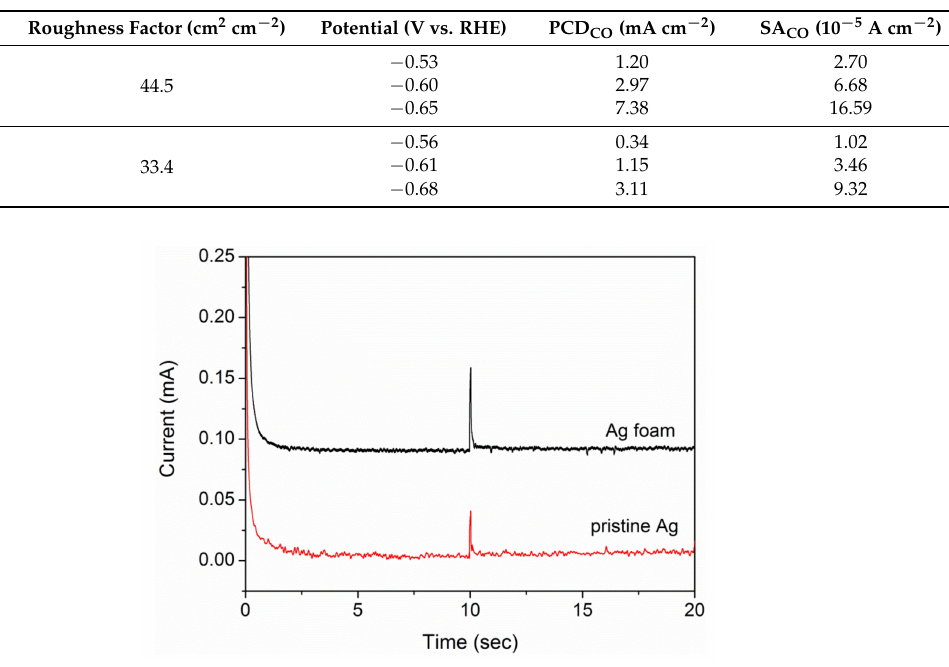
Figure 9. Potential-step curves of the Ag foam and pristine Ag electrodes.